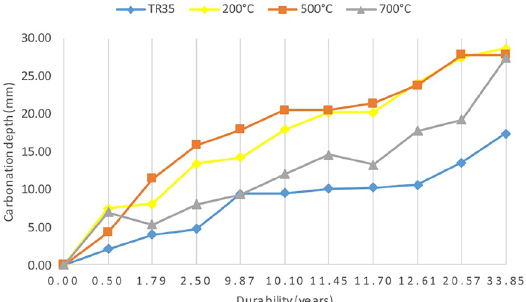
Figure 4. Carbonation depth versus durability for 35 MPa concrete quickly